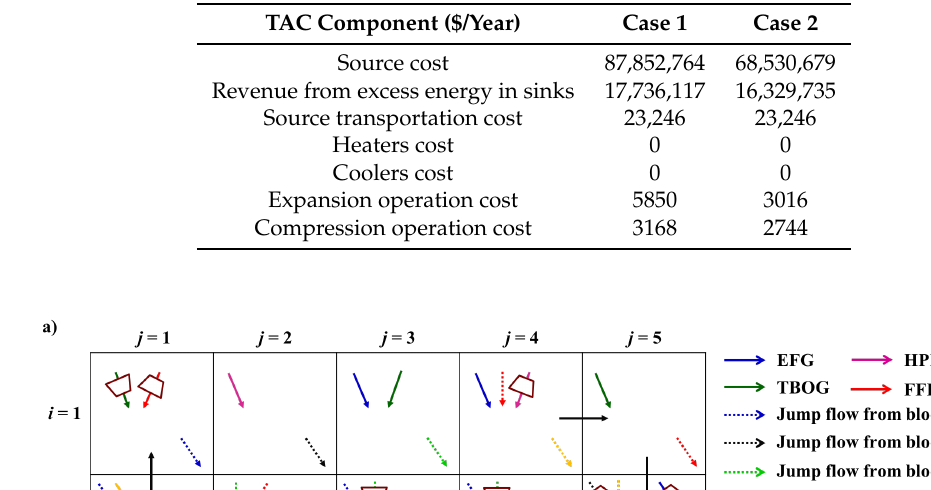
Table 6. Total annual cost comparison for case 1 and case 2.